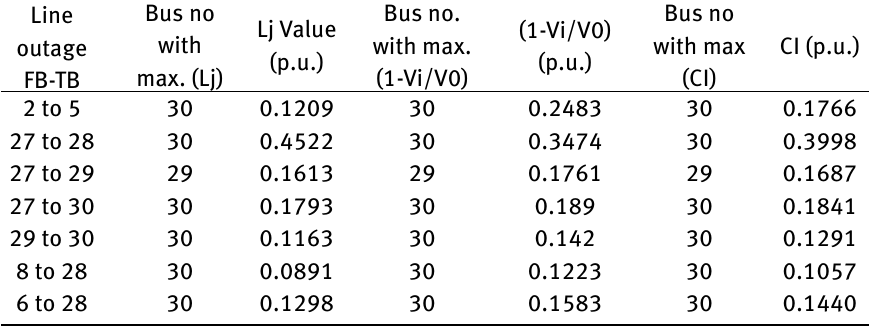
Table 5: Lj,Vi/v0 and CSI values of for some line outage of IEEE 30 Bus Test System Line